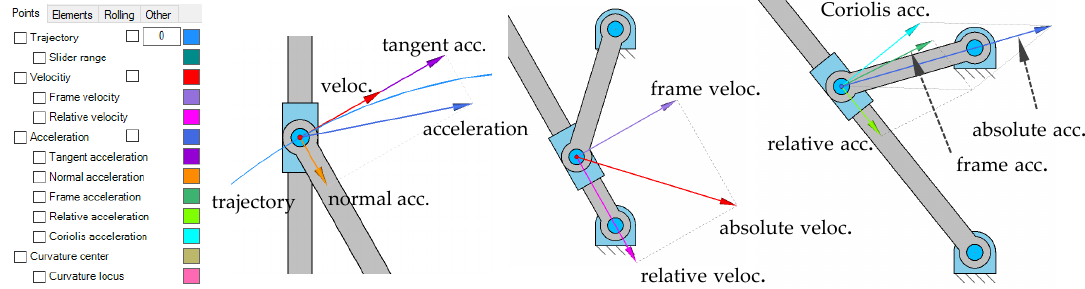
Figure 8. Disk element fixed and moving centrodes in absolute and relative motions. Velocities of poles.